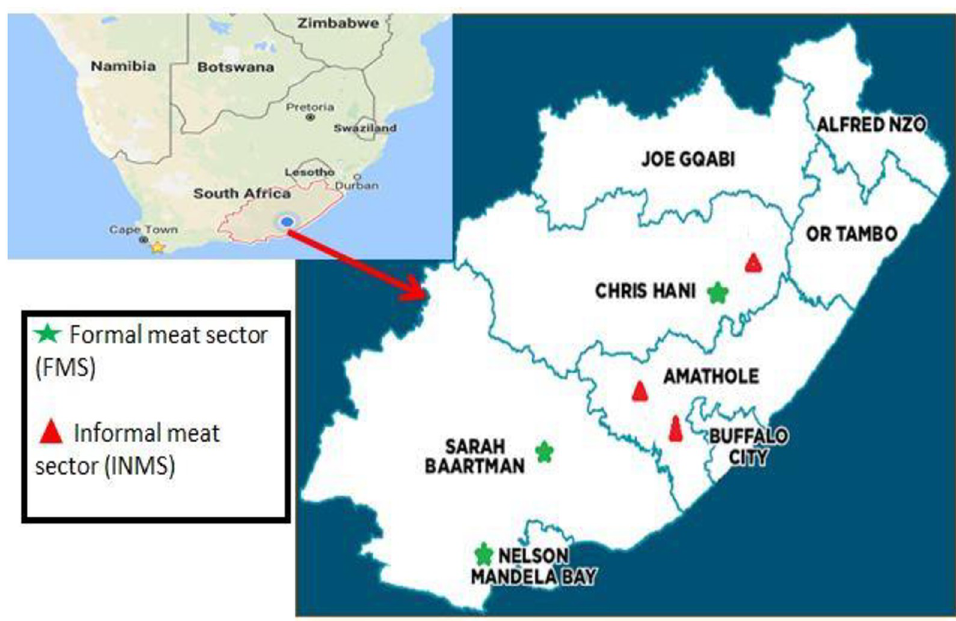
Fig 1. Map of the South Africa with a pointer showing the map of the Eastern Cape Province. The green star show the sampling site for formal meat sector (FMS), and the red triangles show sampling points in the informal meat sector